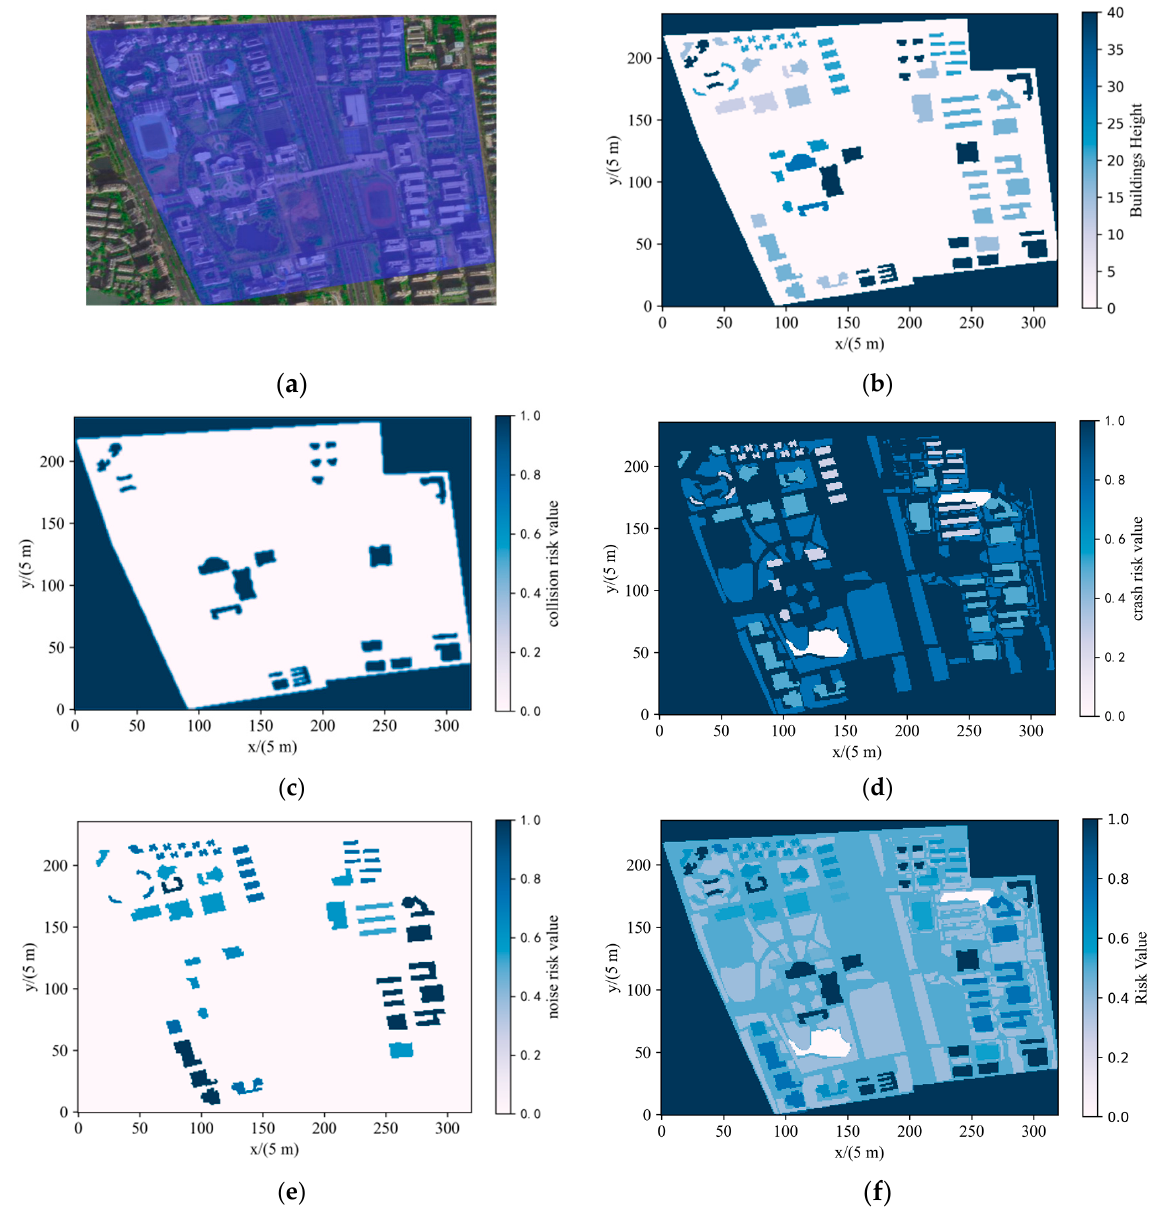
Figure 8. Grid attribute map. ( a ) Real map of the simulation scene. ( b ) Obstacle height map. ( c ) Grid collision-risk value. ( d ) Grid crash-risk value. ( e ) Grid noise-risk value. ( f ) Grid comprehensive risk value.